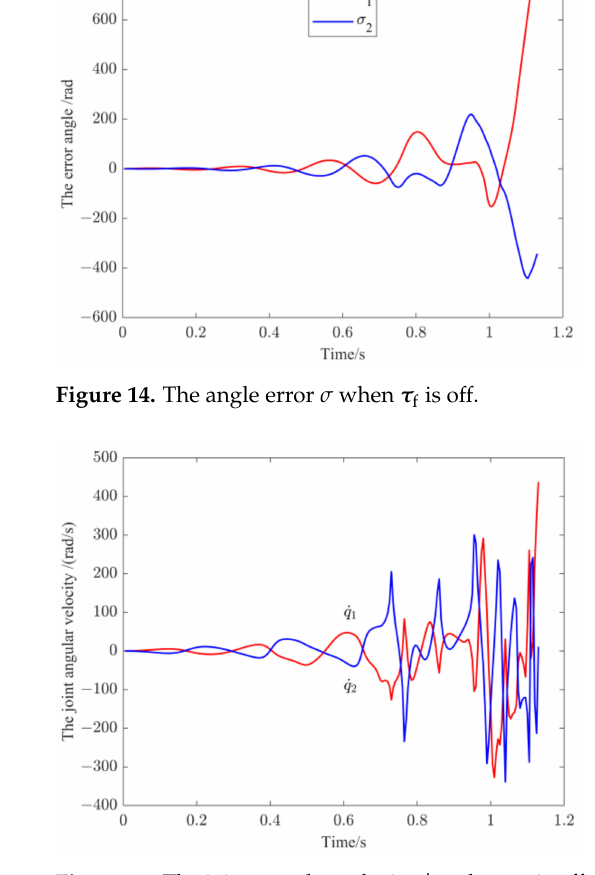
. q when τ f is off. θ